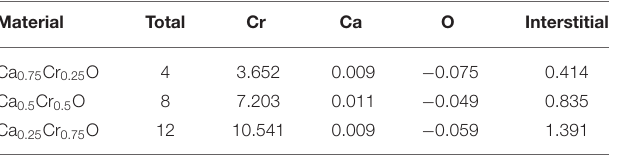
TABLE 3 | Computed total and partial magnetic moments of the relevant Cr, Ca, and O atoms and in the interstitial sites (in Bohr magneton µ B ) for Ca 1-x Cr x O at concentrations x = 0.25, 0.5, and 0.75.